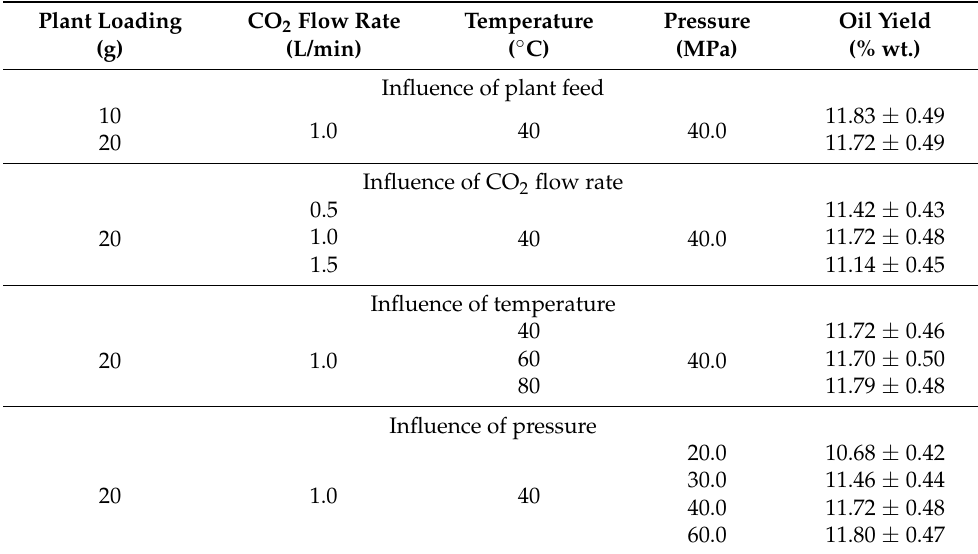
Table 1. Operating conditions and overall oil yield ( ± SD) of supercritical CO 2 extraction of rice bran (cultivar